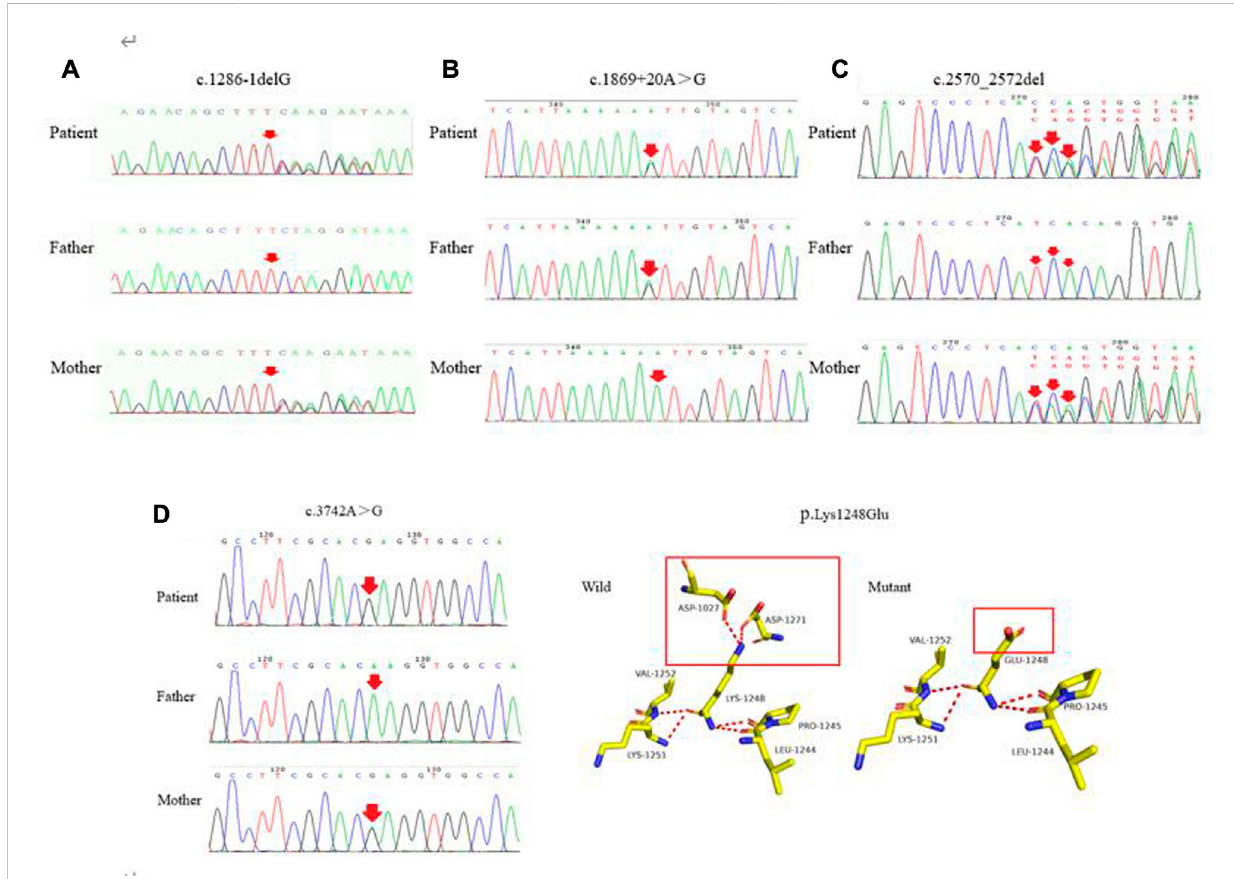
FIGURE 4 (A – C) represent the novel mutations (c.1286-1delG, c.1869 + 20A > G, c.2570_2572del), respectively. (D) c.3742A > G was detected in the patient andhismother. Asshowninthestructureof ATP7B protein,eachcolorrepresentsdifferentatoms,yellow-Catom,gray-Hatoms,blue-Natoms,red- O atoms, orange - S atom, the red dotted line for the hydrogen bond. The red rectangles represent areas of